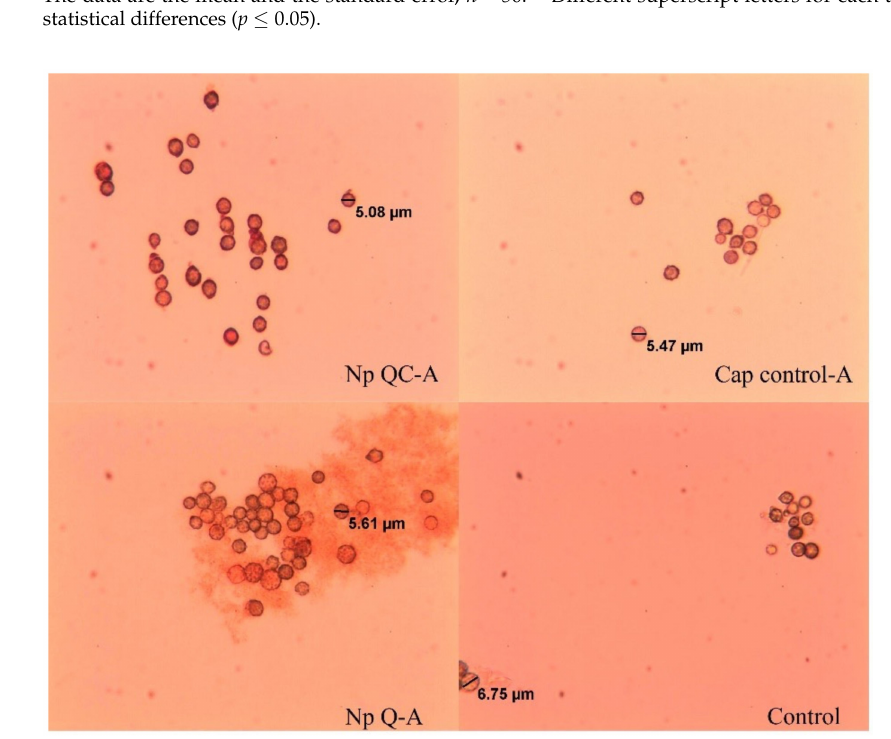
Figure 4. Spores of A. parasiticus grown in Czapek liquid media with an added Np Q-A, Np QC-A and capsaicin solution (Cap control-A), and control (liquid media), at 8 h after inoculation. The images were taken at 40 ×